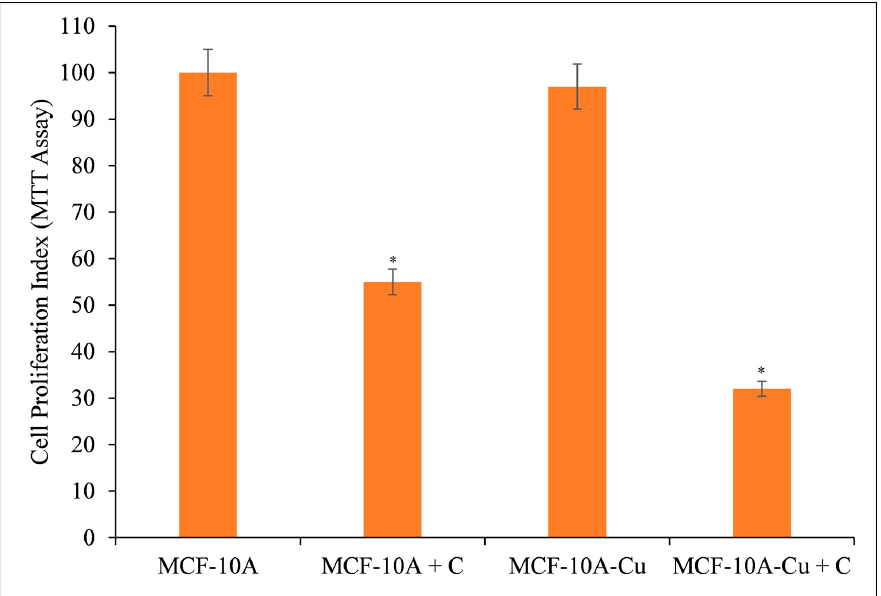
Figure 9. Curcumin’s effect on the inhibition of cell growth in MCF ‐ 10A (normal breast epithelial cells) and MCF ‐ 10A cells cultivated in Cu(II) ‐ supplemented medium (MCF ‐ 10A+Cu). Curcumin